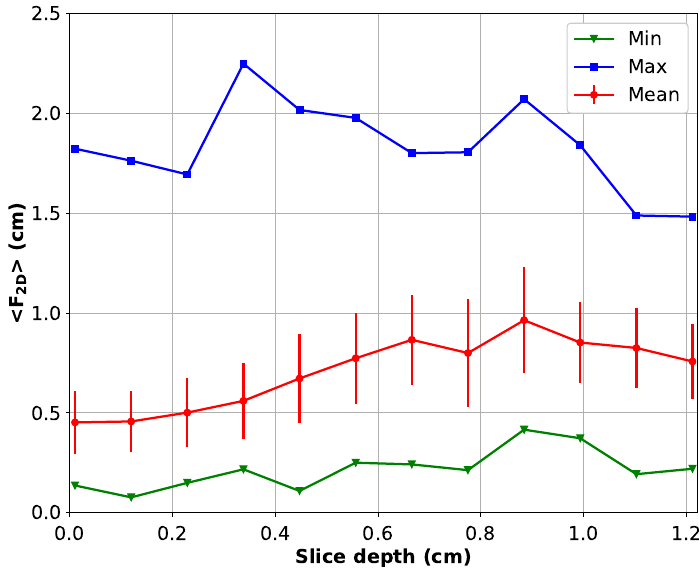
Figure 5. Evolution of the mean 2D Feret diameter on all the slices.